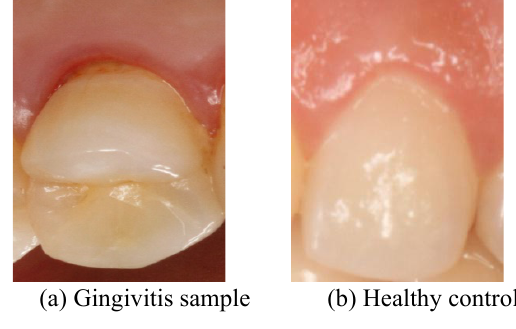
Figure 4. Image Sample of